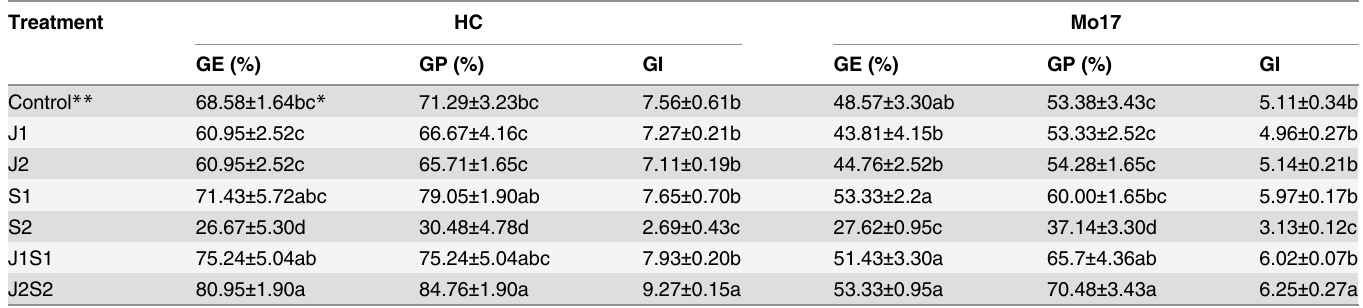
Table 2. Effect of coating agent on maize seed germination under chilling stress. Treatment